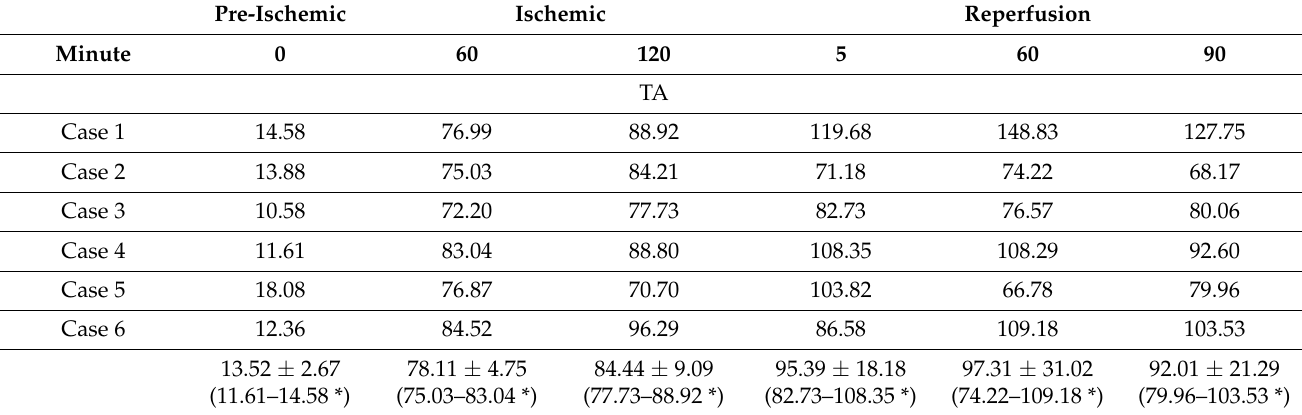
Table 3. The signal intensity values of the anterior tibialis muscle (TA) and gastrocnemius muscle (GA). Pre-Ischemic Ischemic